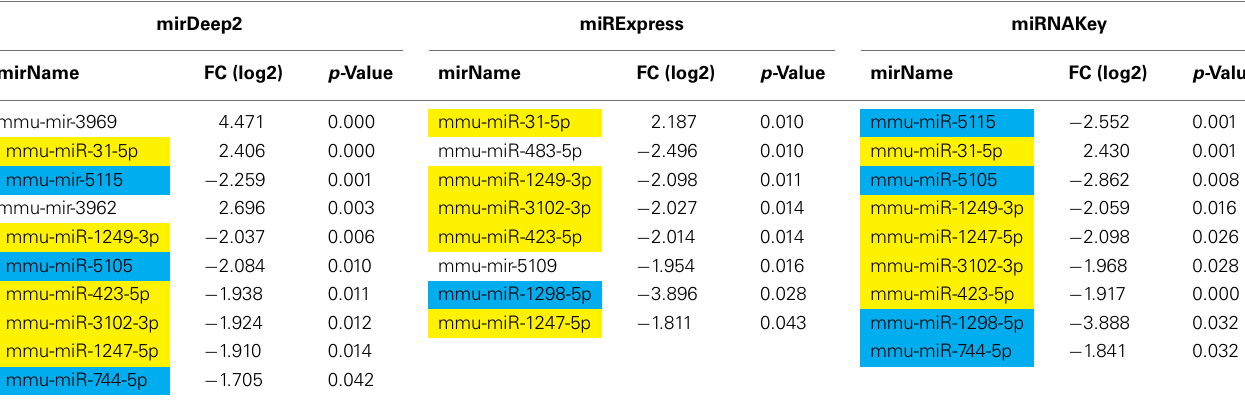
Table 2 | Differentially expressed genes in the Gastrocnemius muscle detected using EdgeR for sham-surgery vs. nerve crush.